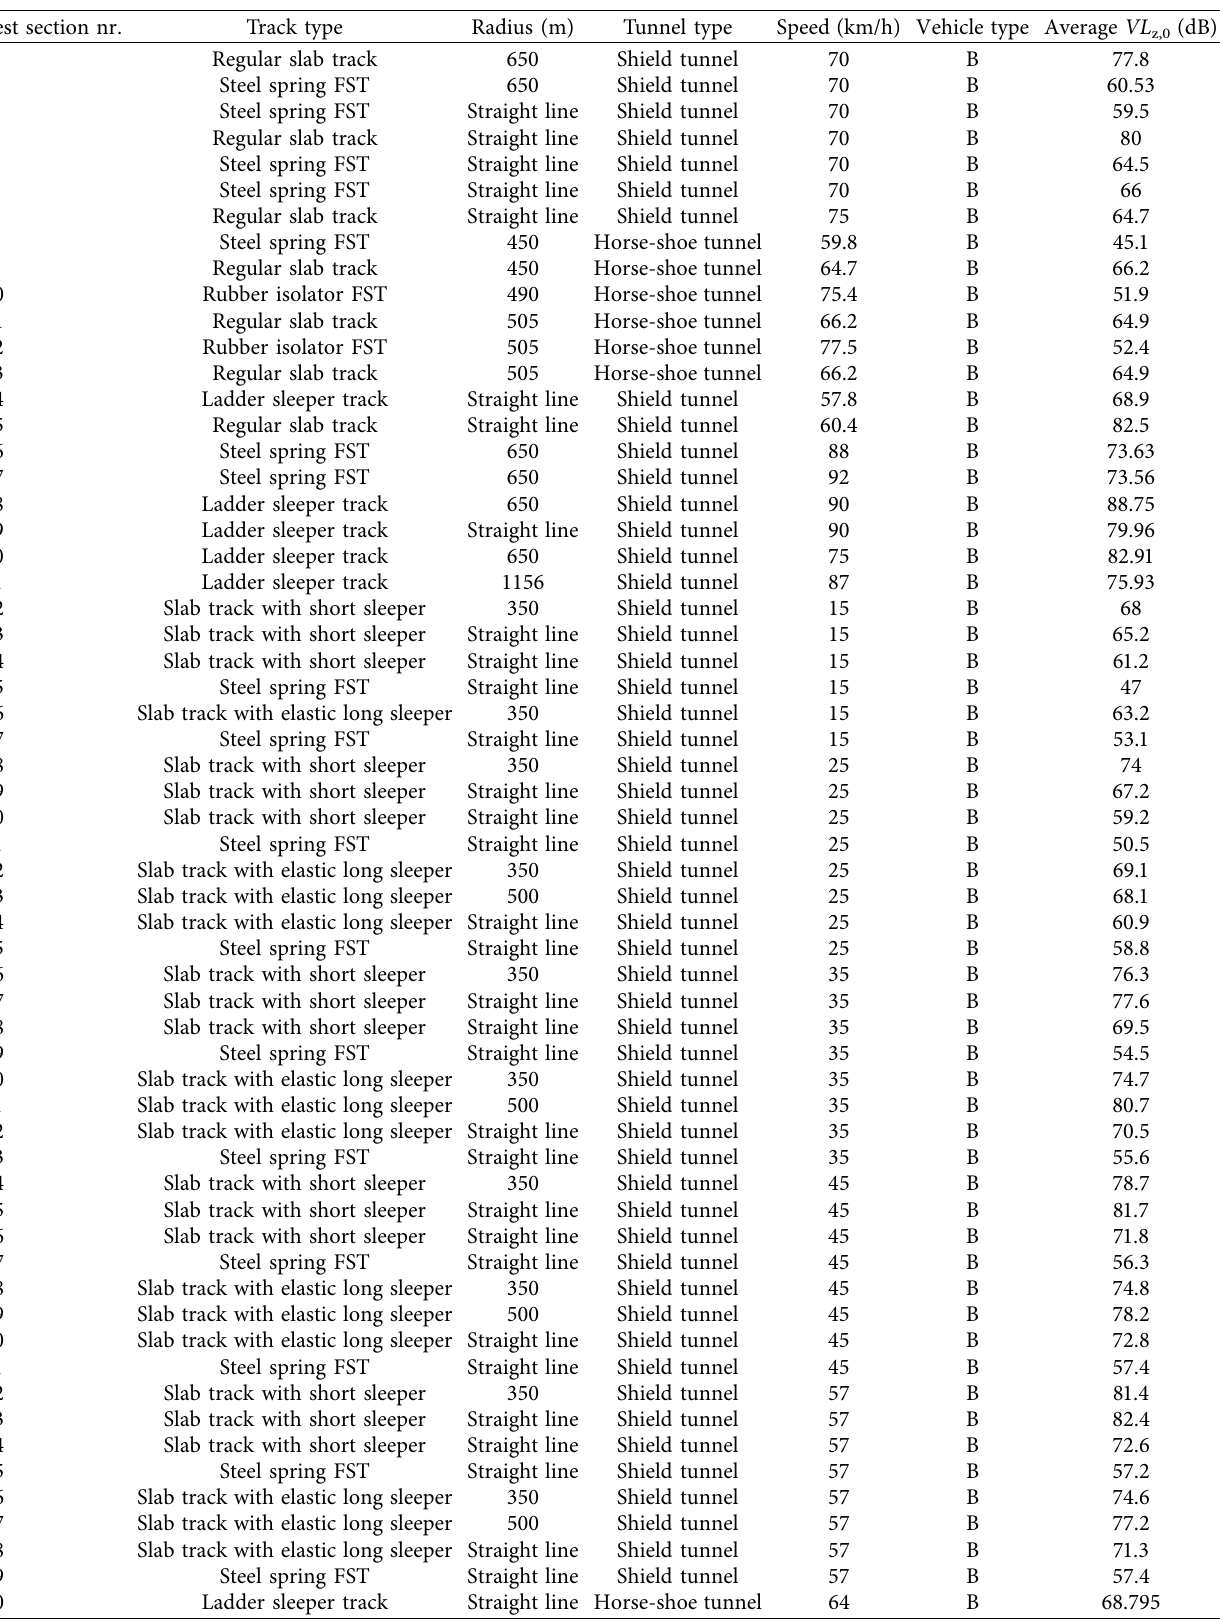
Table 1: Average source intensity and parameter of 80